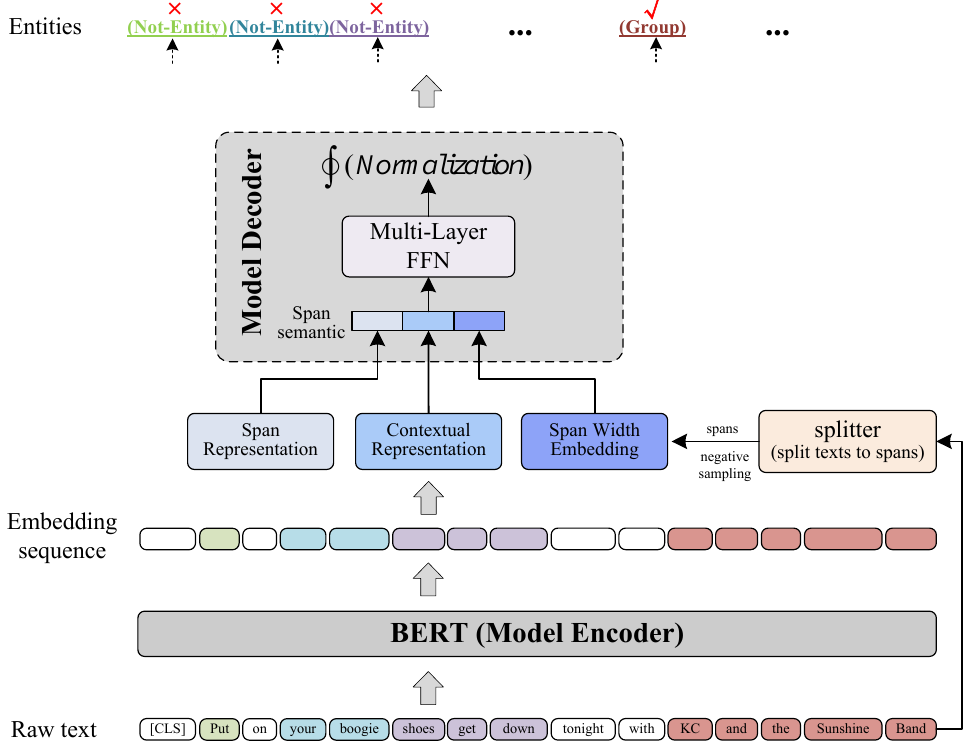
Figure 2. Overall view of S-NER. Text tokens with the same background color (except white) are span examples, such as “Put”, “your boogie”, “shoes get down”, “KC and the Sunshine